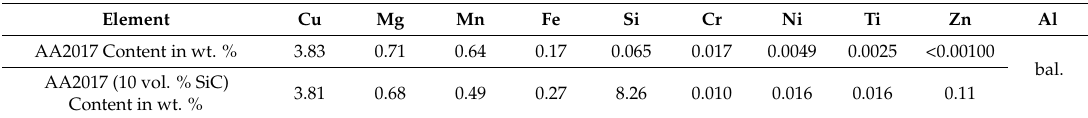
Table 1. Chemical composition of the age-hardenable Al-Cu alloy AA2017 and of the particle reinforced AA2017 composite material (with 10 vol. % SiC). The base compositions of both materials (i.e., of the alloy vs. the matrix-forming alloy of the composite) are very similar, allowing for a direct comparison of the mechanical